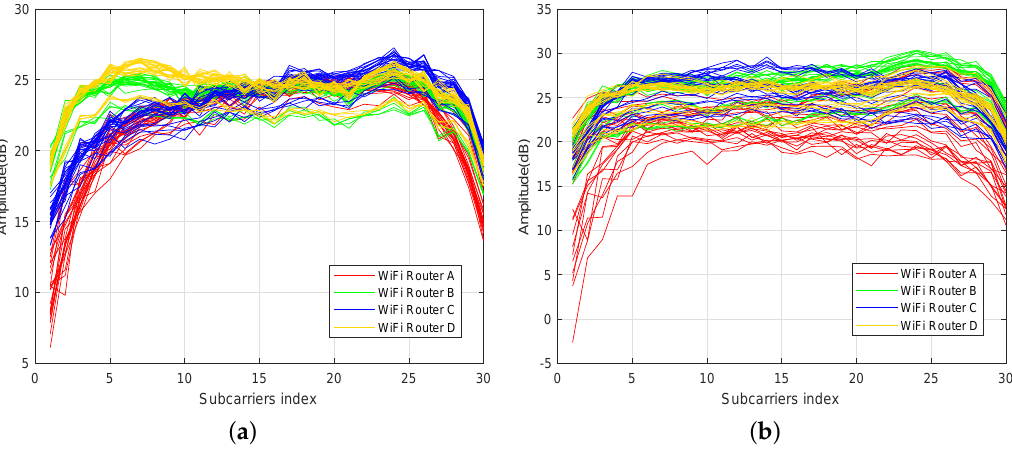
Figure 3. The measured amplitudes of the channel frequency response over 250 s from four different WiFi routers at two different locations of 50 received packets. ( a ) Channel state information (CSI) data at location 1. ( b ) CSI data at location